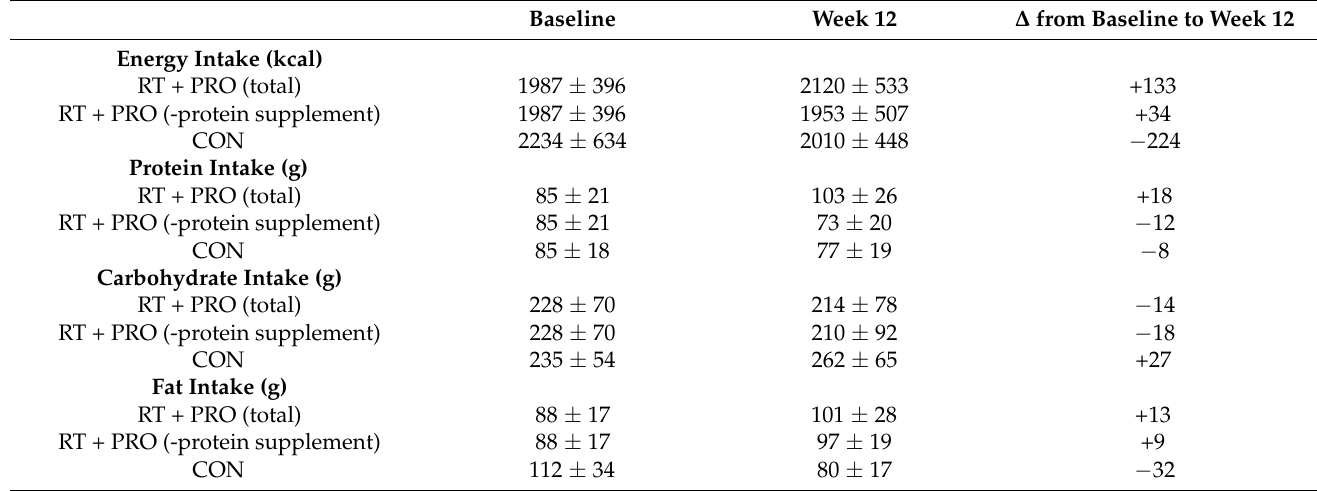
Figure 8. Daily EI in CON (white bars; n = 15) and RT + PRO (black bars; n = 15) groups for baseline and week 12. An Asterisk (*) represents a significant difference from baseline to Week 12. Values are presented as mean ± SE. EI = Energy Intake, RT + PRO = resistance training and protein group, CON = control group. Table 5. Daily energy intake and macronutrient intake across groups with and with the protein supplementation for RT + PRO.